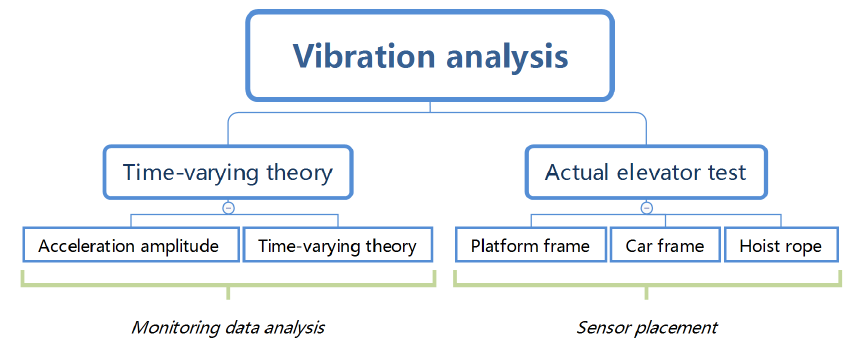
Figure 1. Research Figure 1. Research workflow.